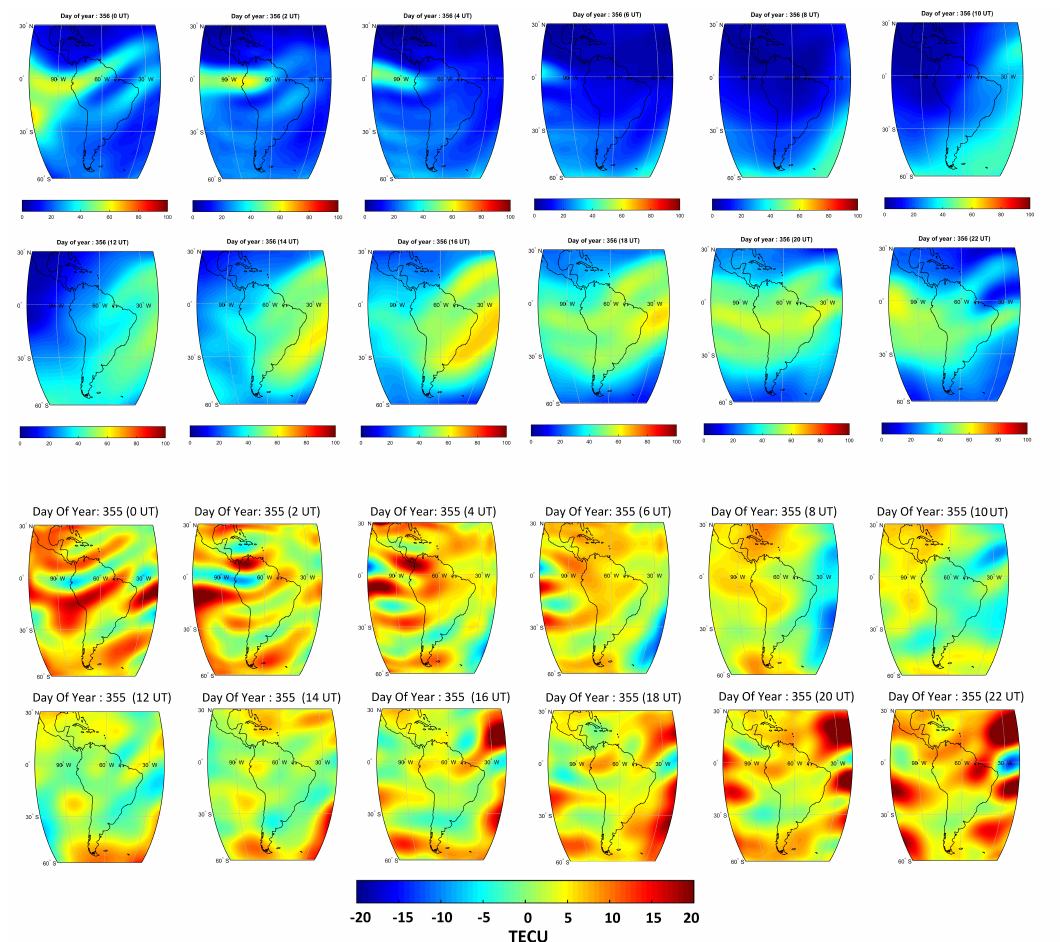
Figure 5. An overview of VTEC changes on 1 December 2013 (DOY 355). The top 12 maps correspond to the regionalized results. The bottom 12 maps are the differences between those of top with the two-hourly GIM/CODE